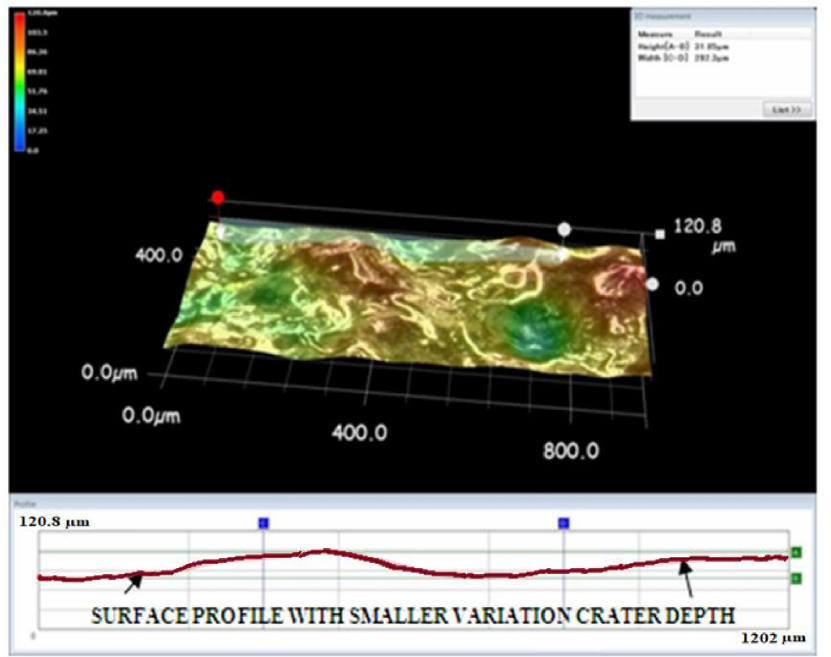
Figure 9. Three-dimensional view of the machined surface using the copper tool electrode.